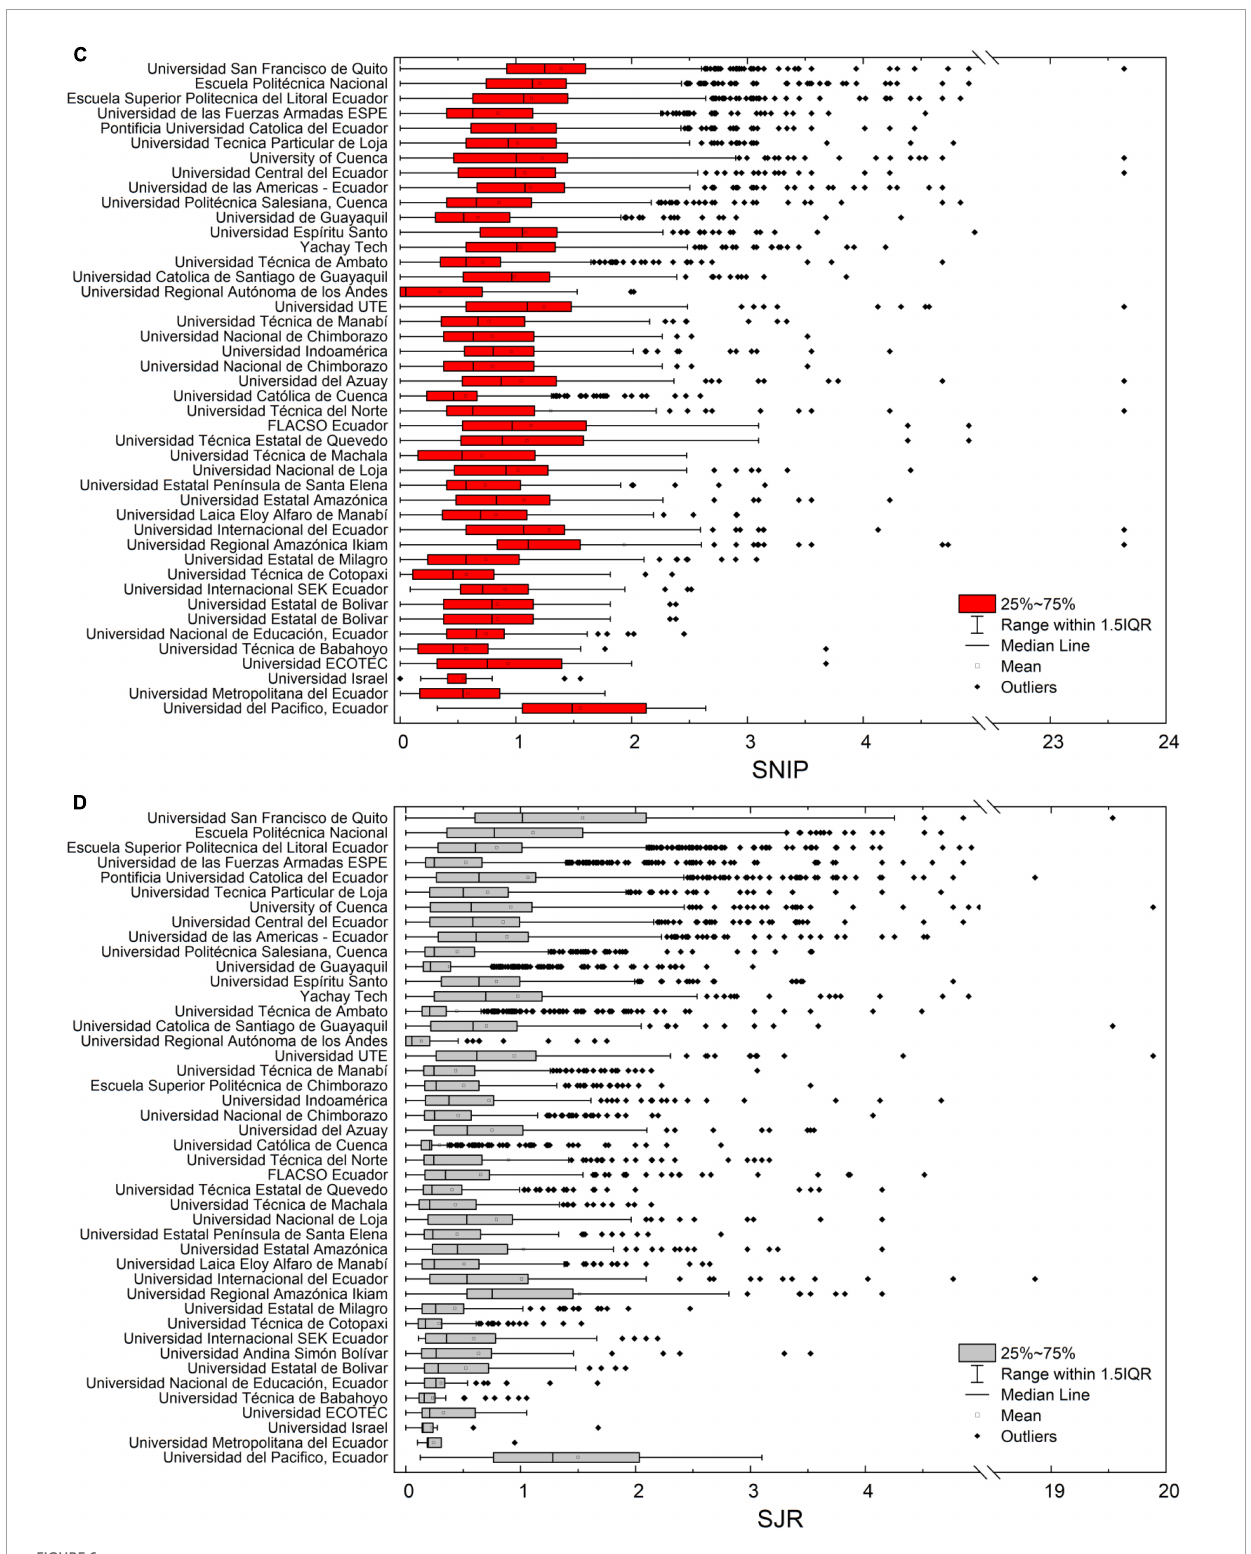
Finally, the lowest eigenvalues were quartile and citations, thus, showing the lowest variability of the whole dataset. Consequently, CiteScore and SNIP were selected as